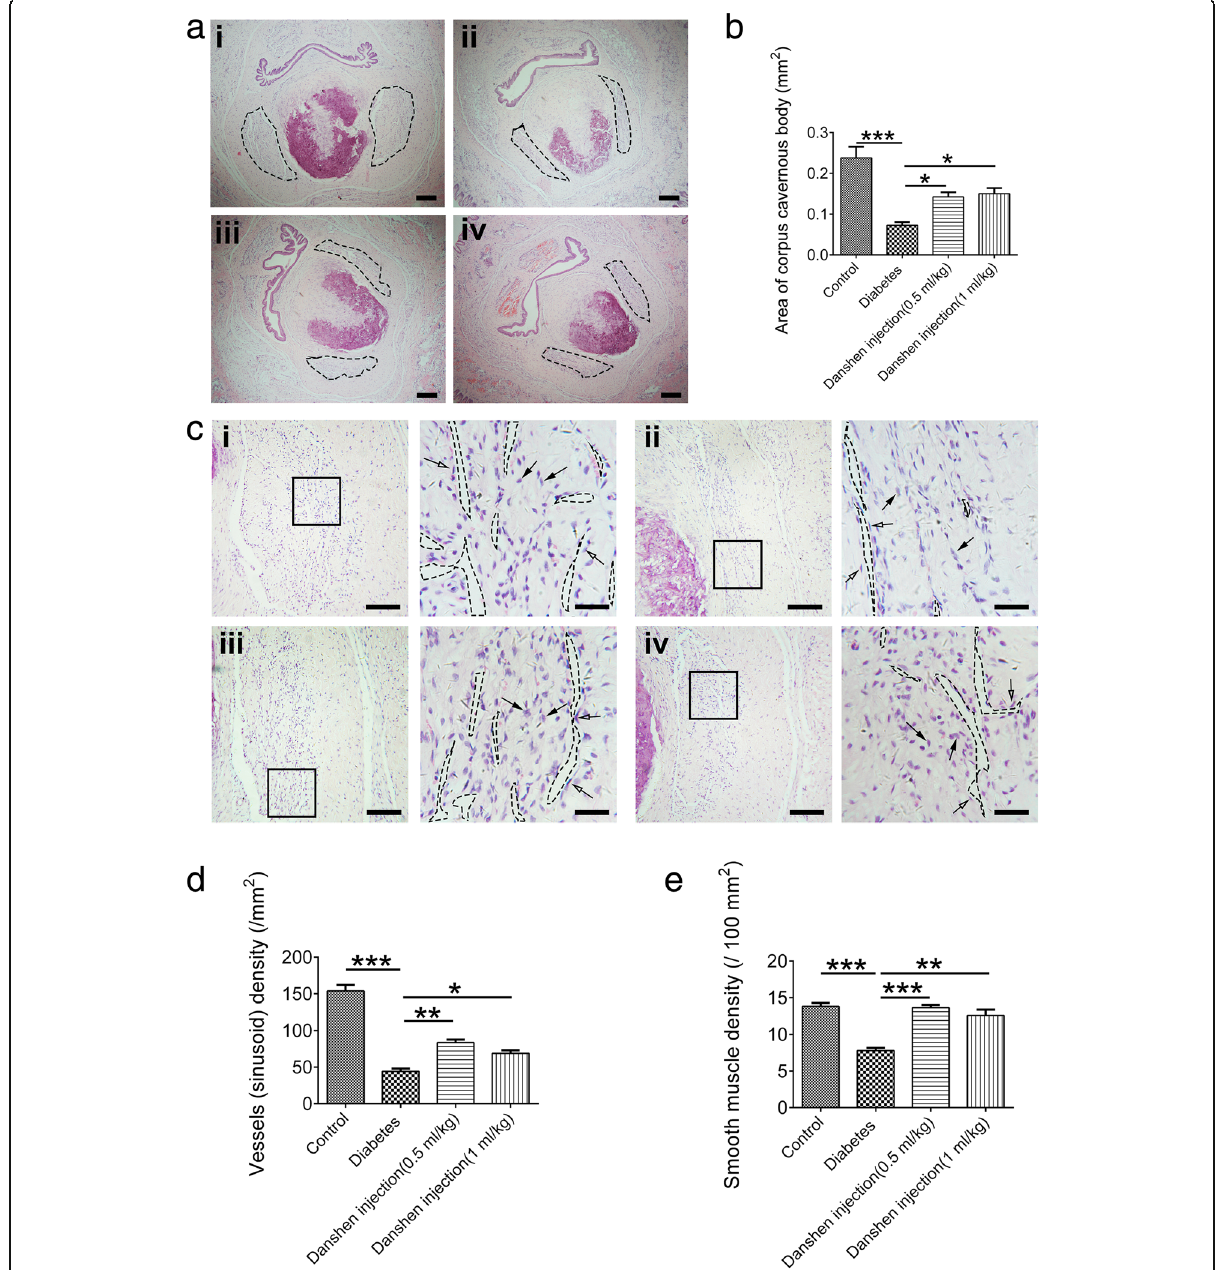
Fig. 3 Danshen injection ameliorated morphological abnormalities of penile tissue in diabetic rats. a The morphology of penile tissue in normal rats exhibited a large, intact architecture of the corpus cavernous tissue, which is indicated by the dotted lines (i). There was significant shrinkage of the corpus cavernous body in the diabetes group (ii); however, the area of the corpus cavernous body was increased by Danshen injection (0.5 or 1 mL/kg) treatment (iii and iv). Scale bar: 200 μ m. b Data represent the means ± S.E.M. for 10 sections of five rats per group. c Significant alterations of vessels (sinusoid) and smooth muscle cells in the corpus cavernous. The density of vessels, which are highlighted by the dotted lines, was surrounded by endothelial cells (indicated by the white arrow); and the number of smooth muscle cells (indicated by the black arrow) in the control group (i) was higher than that in the diabetes group (ii). Danshen injection (0.5 or 1 mL/kg) could rescue the reduction of vessel and smooth muscle cell density (iii, iv). The inset in each picture (Scale bar: 200 μ m) is enlarged and displayed on the right (Scale bar: 50 μ m). d , e Bar graphs represent the quantitative difference in the density of vessels (sinusoid) and smooth muscle cells. Data represent the means ± S.E.M. for 10 sections of five rats per group. * P < 0.05; ** P < 0.01; *** P <